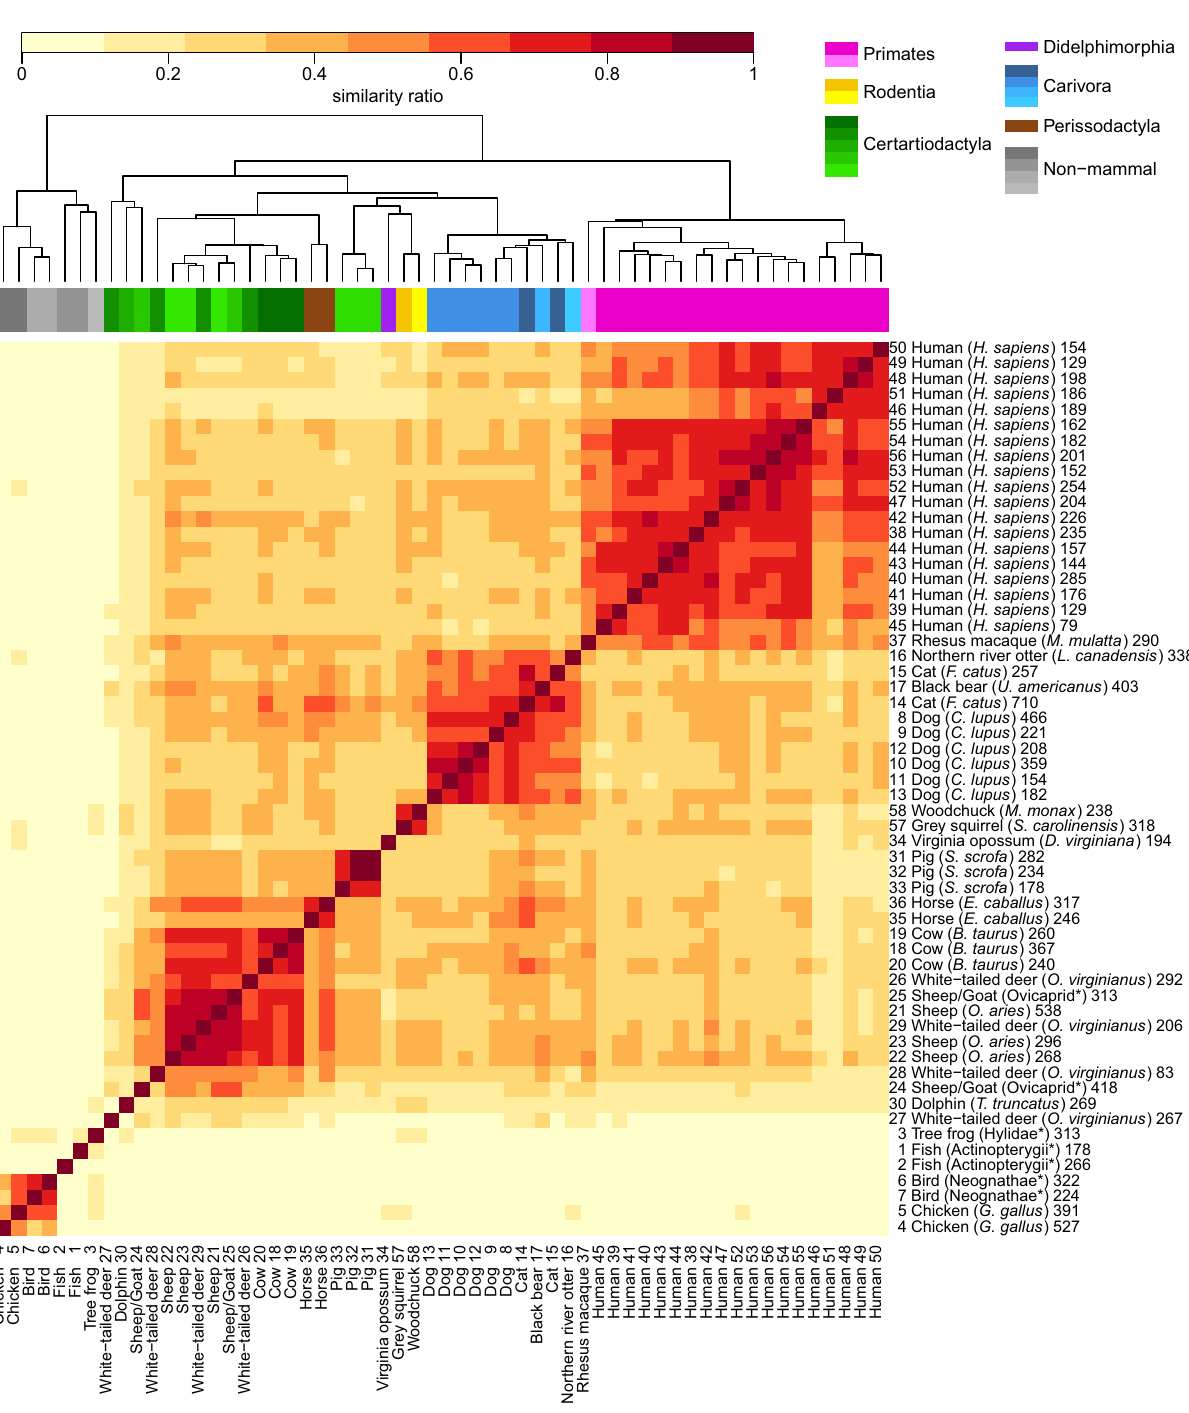
package PYMC3. Figure 5 (see also Supplemental Table S12) shows that the spectra method of organizing data had the best estimate of out-sample-accuracy (i.e. lowest deviance), particularly for species and order. As such, subsequent analyses were performed using spectra ratios.